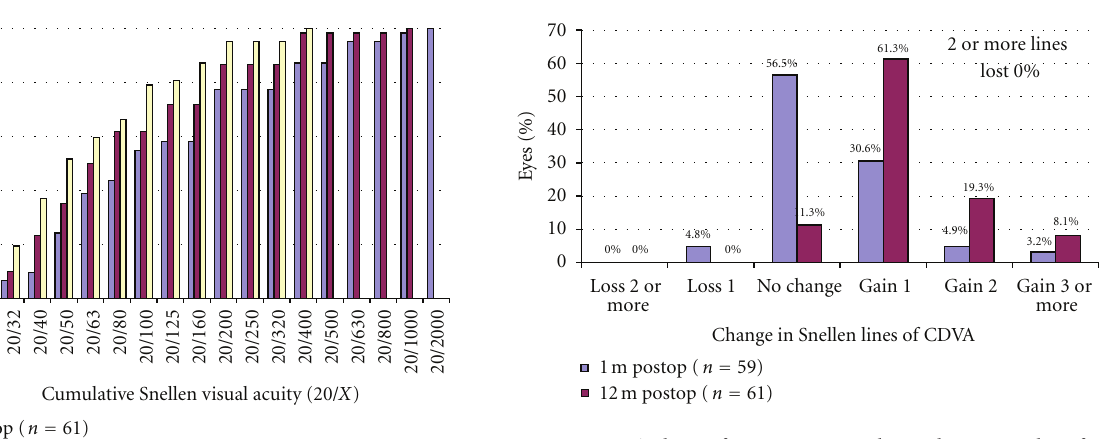
Figure 1: . Slit lamp verification of the stromal riboflavin saturation before the UVA irradiation.